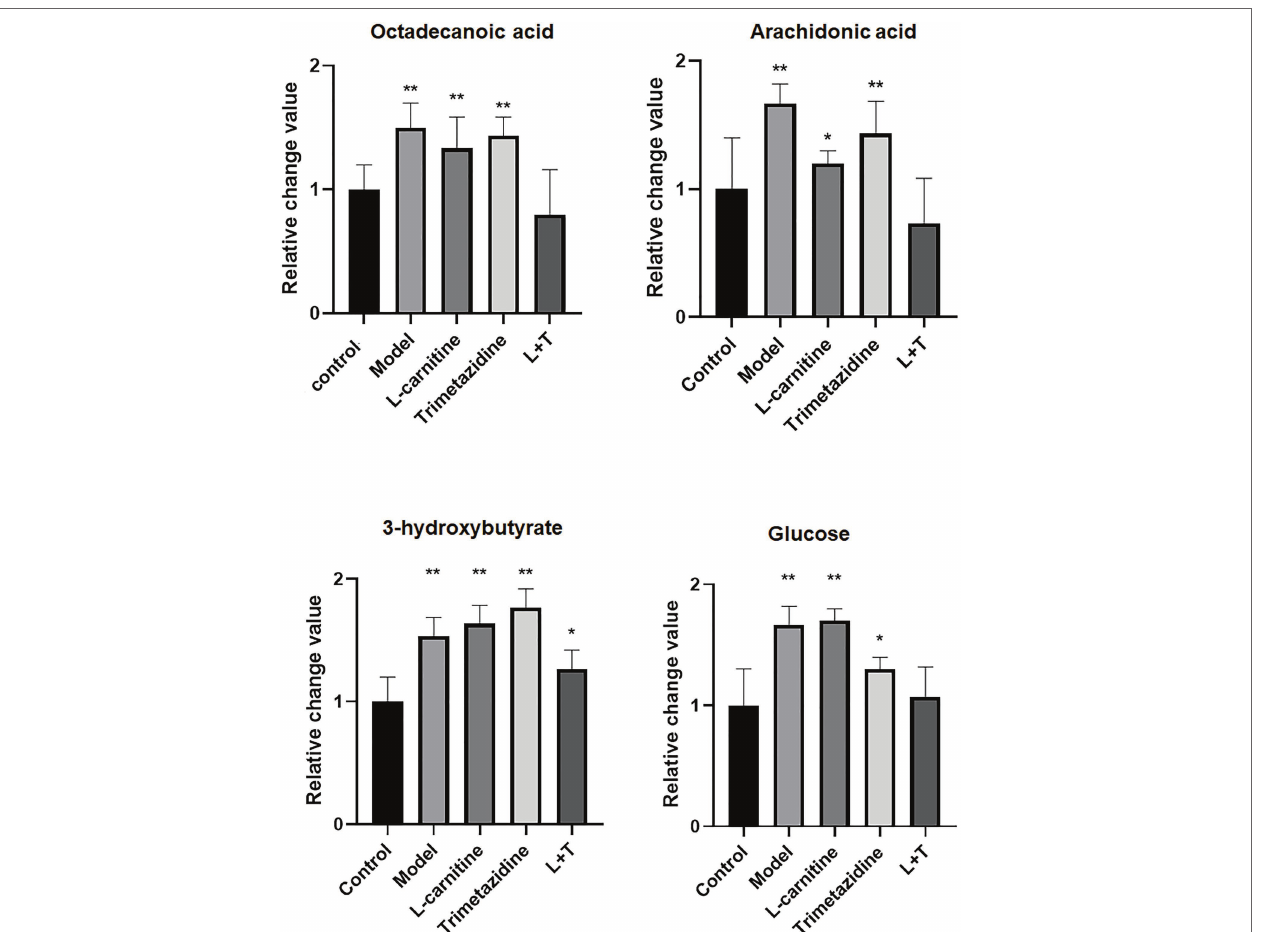
FIGURE 3 | A quantitative map of comparison of key metabolites in the myocardial tissue. LT represents l -carnitine combined with the trimetazidine group. * p < 0.05 and ** p < 0.01 compared with the control